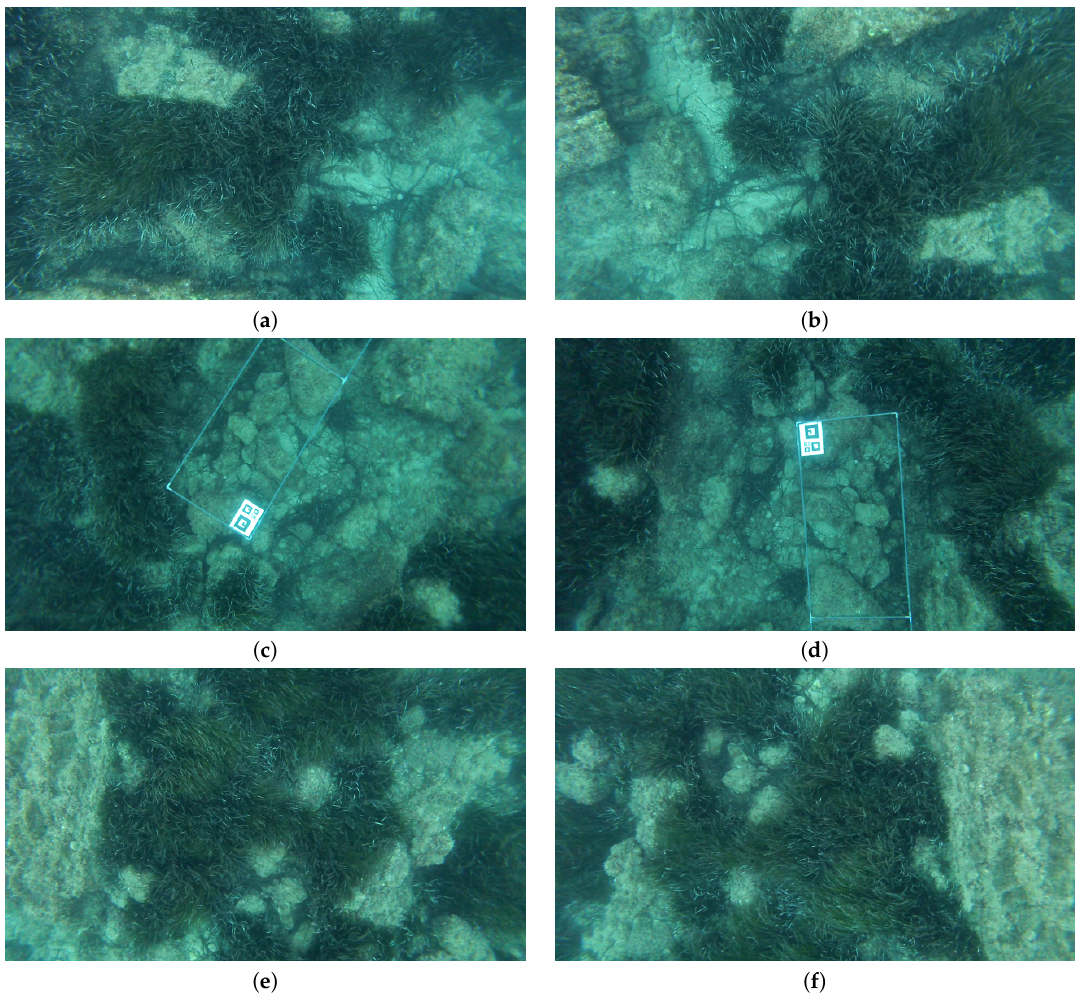
Figure 10. Local loops of sequences V 3 and V 4: Each image in the left column closes a loop with the corresponding image in the right column. ( a , b ) Sequence V 3, Image 67 with Image 79. ( c , d ) Sequence V 4, Image 155 with Image 208. ( e , f ) Sequence V 4, Image 162 with Image 171.